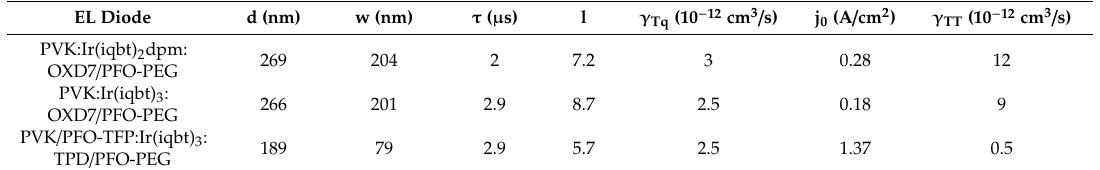
Table 1. The values of the parameters used for fitting the OLED EQEs’ data as well as the values of the Tq and TTA rate constants from the reproduction